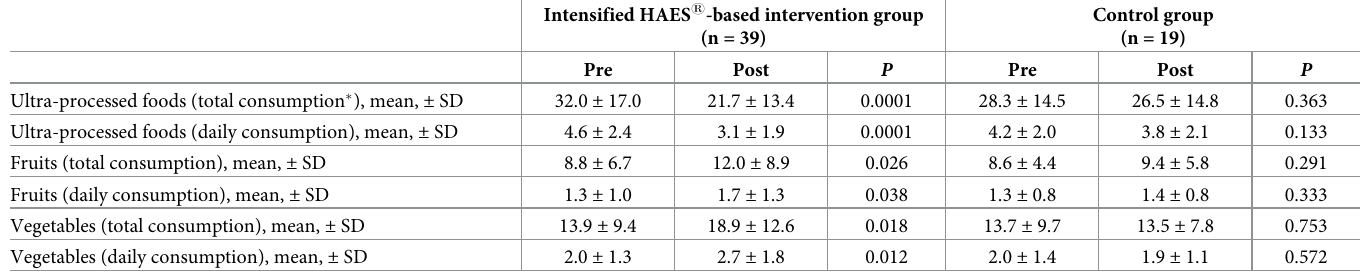
Table 5. Dietary frequency intake of ultra-processed foods, fruits and vegetables of women participating in a randomized controlled trial based on the Health at Every Size 1